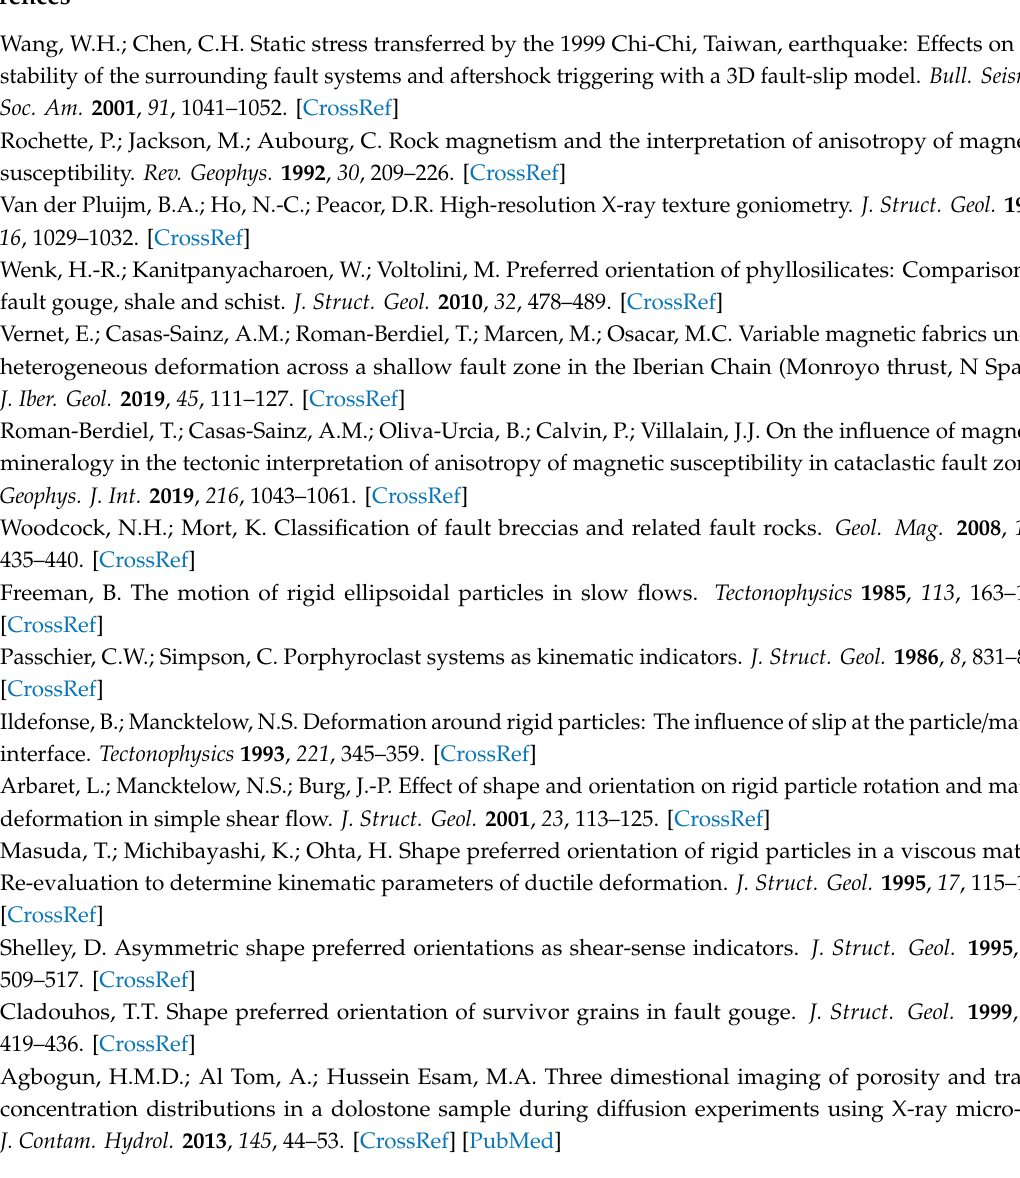
Figure S1: The distribution of grain size and aspect ratio of investigated grains, Figure S2: Anisotropy, elongation, and flatness distributions of the investigated grains, Figure S3: Scanning Electron Microscope Back-Scattered Electron (SEM-BSE) image of BK-1 sample, Table S1: The total SDI data of the BK-1